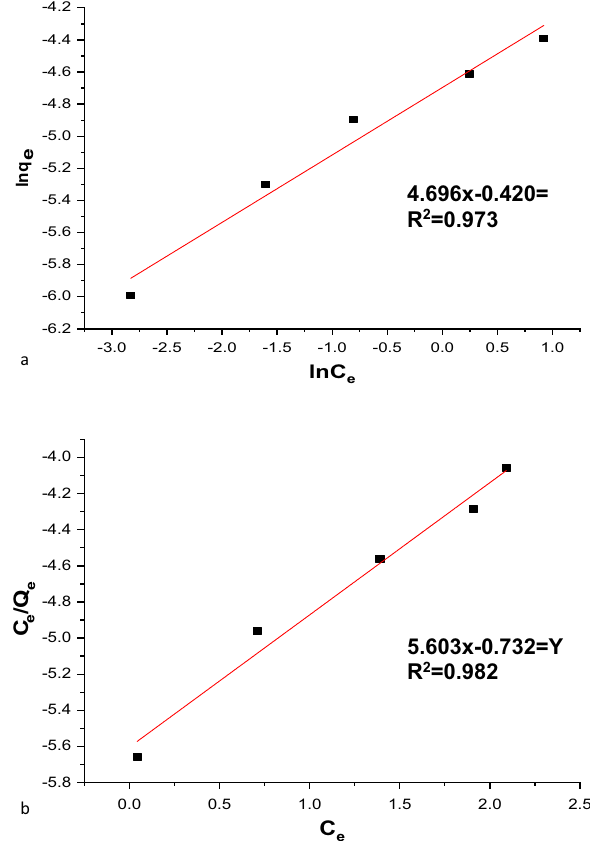
Figure 18. Freundlich ( a ) nano bentonite and ( b ) MgO impregnated clay plots for adsorption of